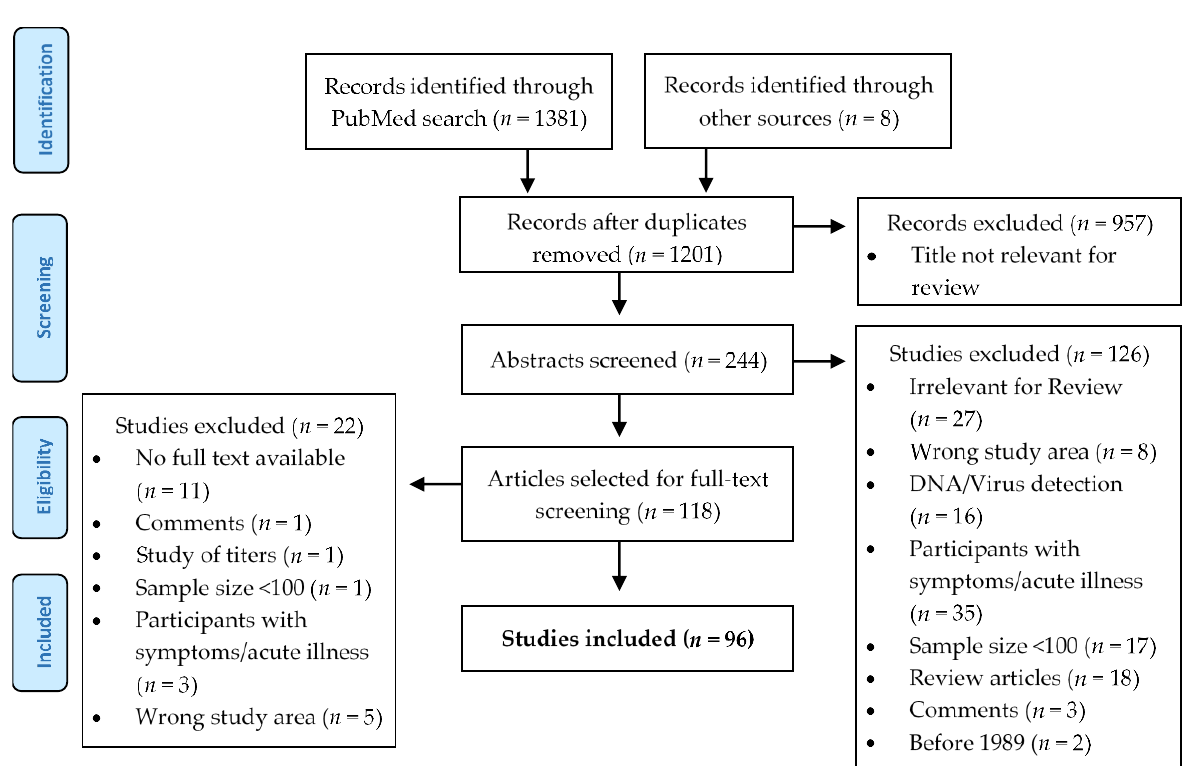
Figure 2. Flowchart of the identification process of eligible articles.